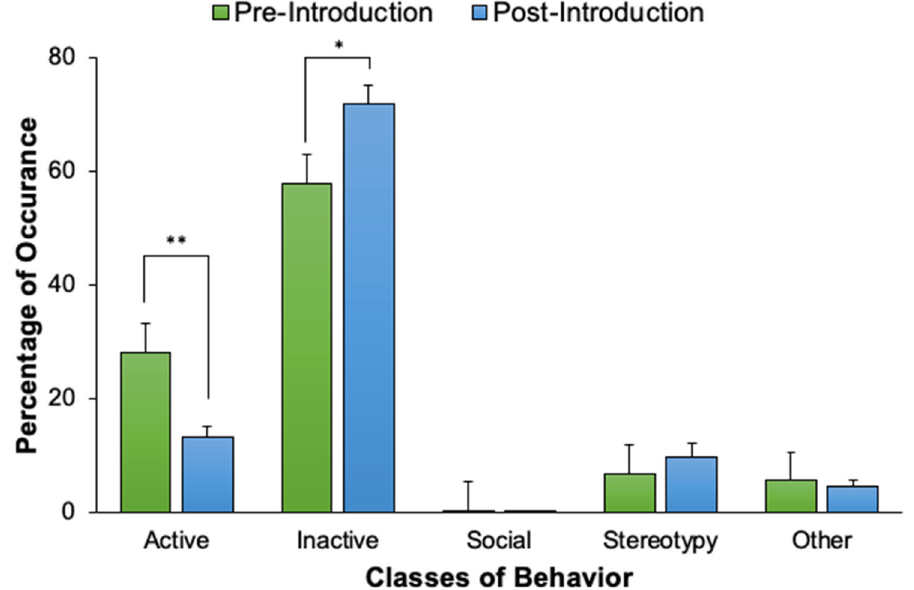
Figure 5. The percentage of occurrence (with standard error of the mean bars) that Barney engaged in each of the five behavior classes, comparing pre-introduction and post-introduction activity levels. Solid lines and asterisks represent statistically significant results in accordance with the Bonferroni correction for Experiment 1 ( α = 0.004). * p ≤ 0.004. ** p < 0.001.